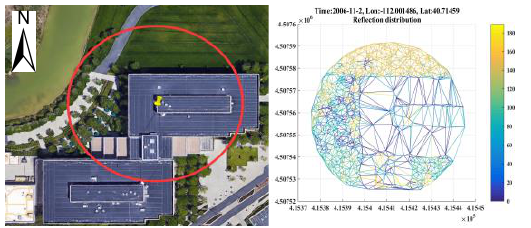
Figure 5. Reflectance distribution of airborne LiDAR data recorded in the GLAS footprint